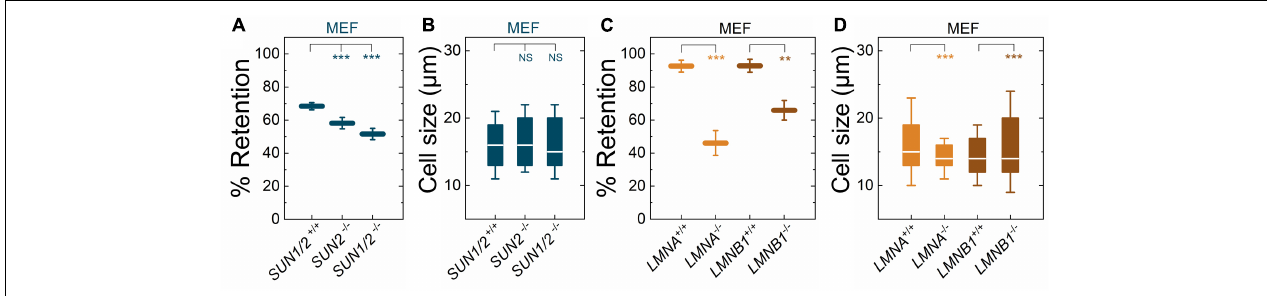
FIGURE 2 | Fibroblasts lacking LINC complexes (SUN1/2, SUN2), A-type lamins (LMNA), or lamin B1 (LMNB1) have increased deformability relative to controls. PMF measurements of the indicated MEF lines. (A) PMF conditions: 10 µ m pore membrane, 2.1 kPa for 50 s. (C) PMF conditions: 10 µ m pore membrane, 2.1 kPa for 40 s. Each data point represents the mean ± SD. Statistical significance was determined using Student’s t -test. (B,D) Cell size data. Boxplots show 25 and 75th percentiles; line shows median; whiskers denote 10 and 90th percentiles. Statistical significance was determined using Mann–Whitney U -test. All data were obtained from three independent experiments. ∗∗∗ p < 0.001; ∗∗ p < 0.01; not significant (NS) p > 0.05.